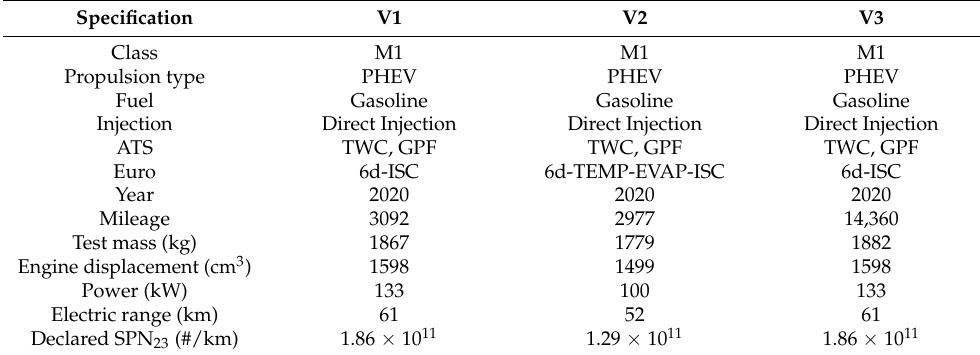
Table 1. Main characteristics of tested